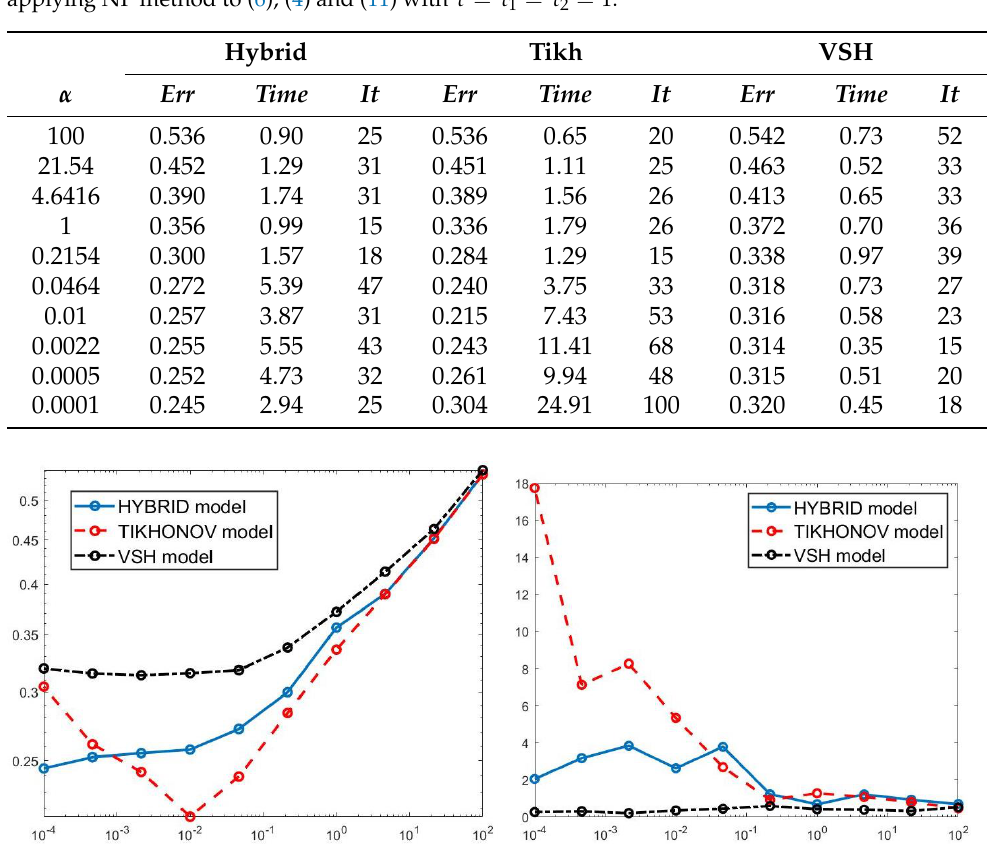
Table 1. Numerical results for the models comparison on simulated NMR data. Results obtained by